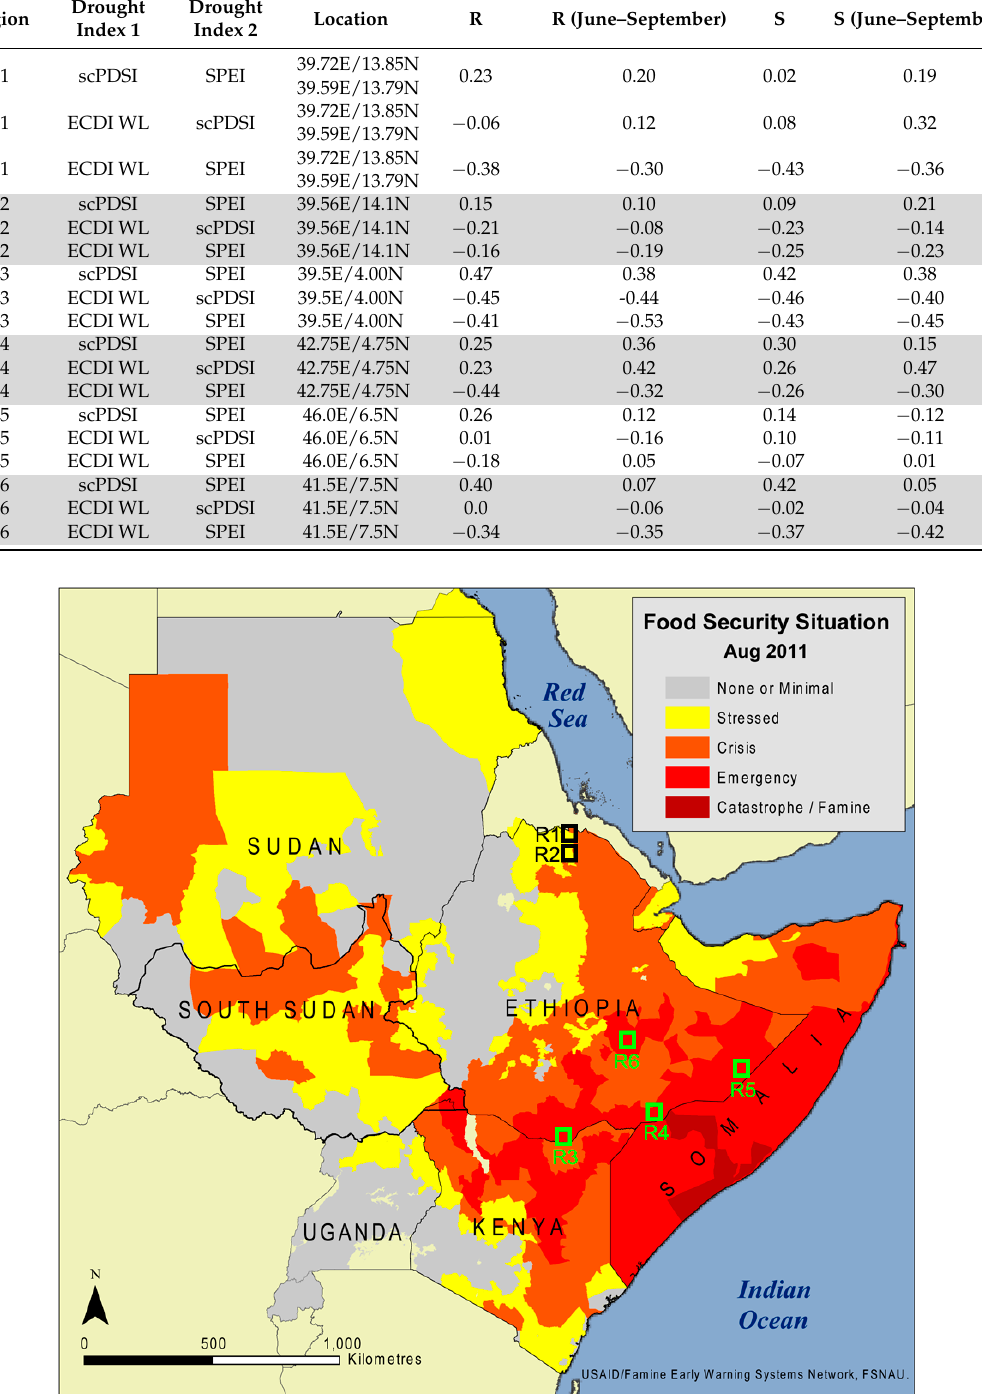
Figure 7. Food Security Situation 2011 according to US AID and the Famine Early Warning Systems network (FEWSNET). Regions of Interest (R) 1 and 2 are located in Tigray, while R3 to R6 are located in zones that were classified as “emergency” during the 2011 drought event.